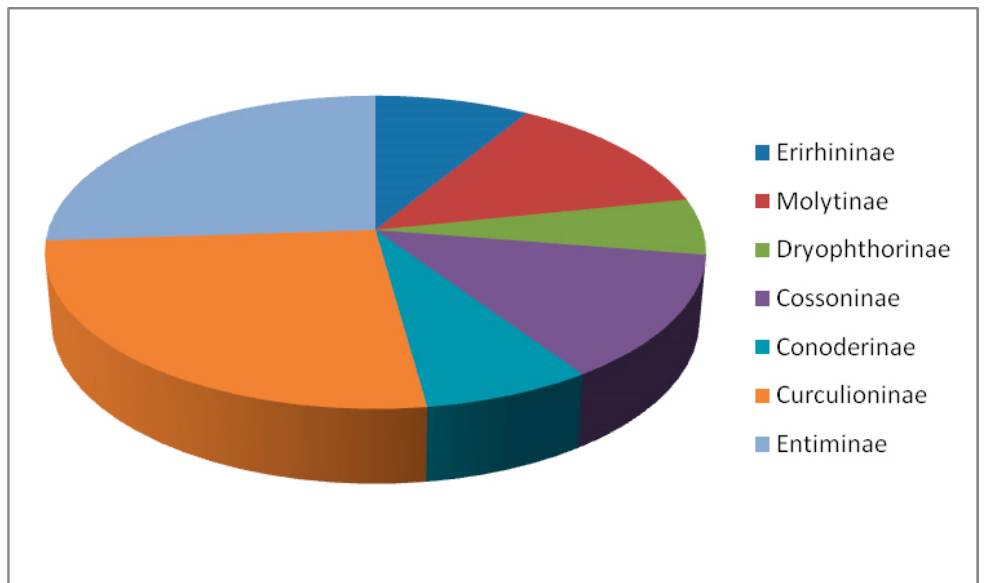
Figure 14. Composition of the subfamilies of Curculionidae from Eocene amber.